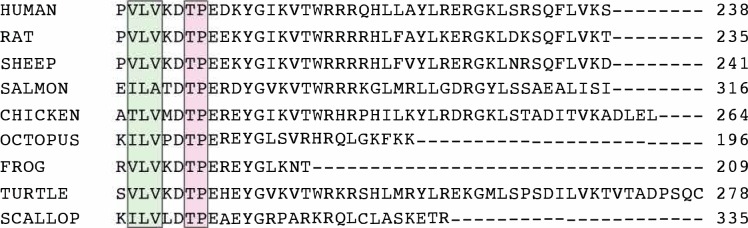
Conservation of the TOPBP1-interacting phosphorylation site in RHINO homologues.Alignment of C-terminal RHINO sequences showing very strong conservation of the TOPBP1-interacting motif identified in human RHNO1 across a broad range of animals. Sequences are from humans (Homo sapiens), rodents (Rattus norvegicus), ruminants (Ovis aries), fish (Salmo salar), birds (Gallus gallus), cephalopods (Octopus bimaculoides), amphibians (Xenopus laevis), reptiles (Chelonia mydas) and bivalves (Mizuhopecten yessoensis).